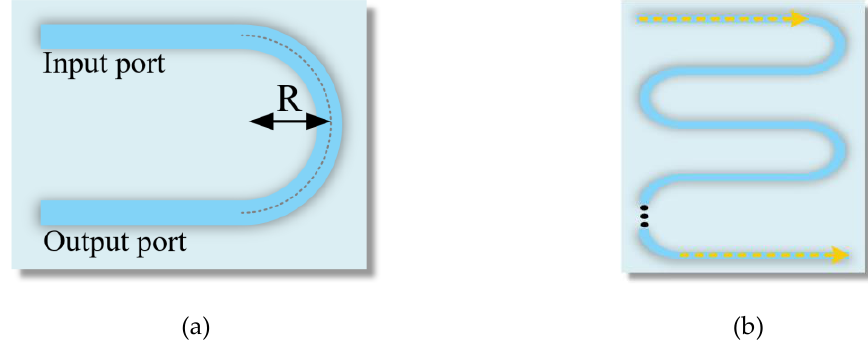
Figure 3. ( a ) Schematic of a semi-circle; ( b ) The S-bend structure for mode discrimination.